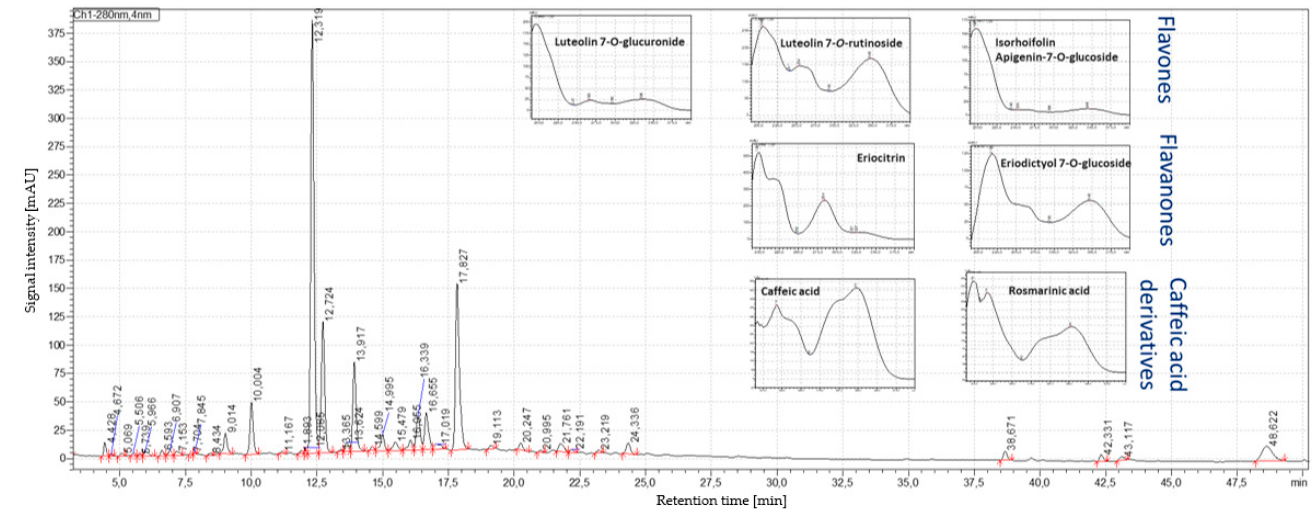
Figure 4. HPLC–PDA profile at 280 nm of the corresponding peppermint extract E2 from Europe. The HPLC–QTOF-MS/MS recording in the negative ionization mode allowed the identification of the major phenolic compounds in the peppermint samples (Table